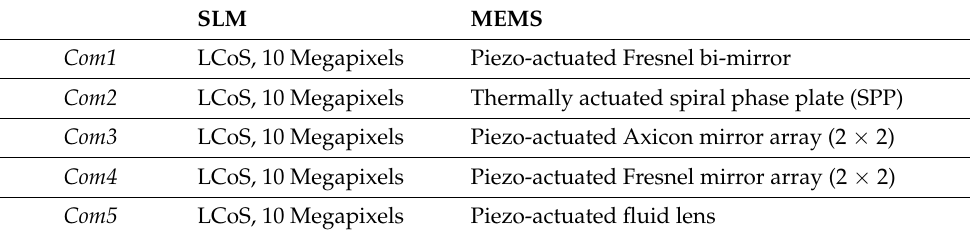
Table 1. Overview of different types of combined systems tested in beam shaping experiments. All arrangements consisted of a high-spatial-resolution, pixelated, phase-only liquid-crystal-on-silicon spatial light modulator (LCoS-SLM, HOLOEYE) and a particular type of actuated optical component (MEMS, IMTEK).